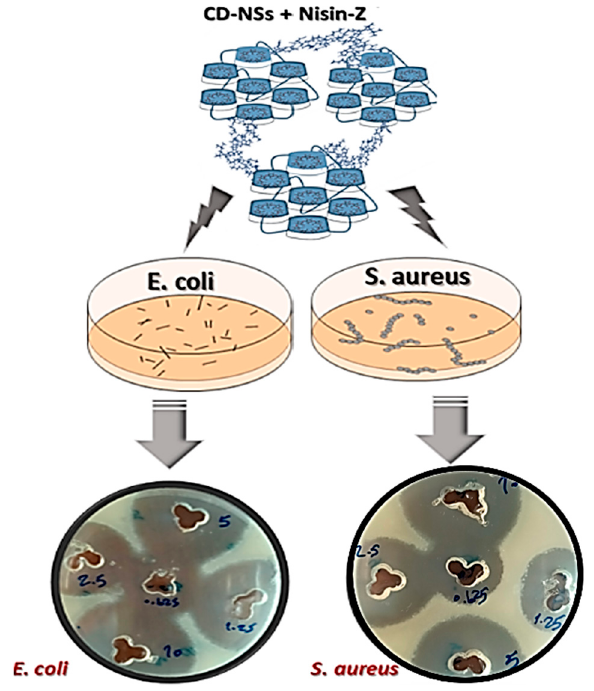
Figure 3. Schematic representation of the anti-bacterial effect of Nisin complexed to CD-NSs.